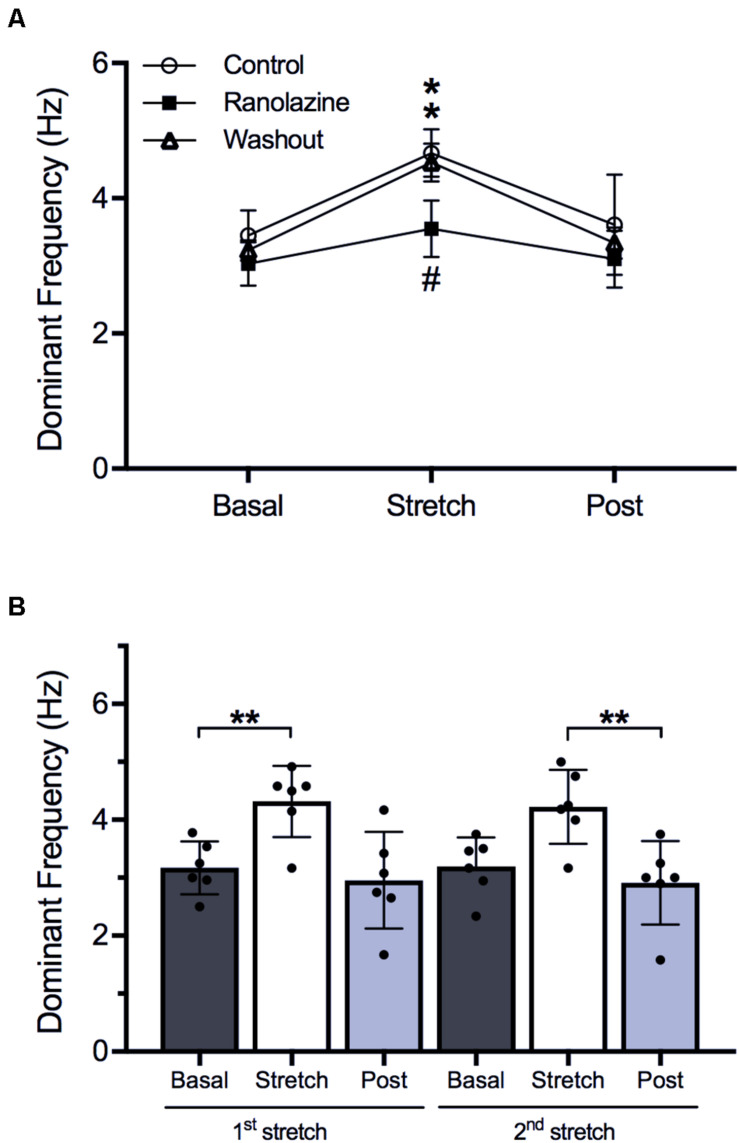
(A) Stretch-induced modifications of dominant frequency under control conditions, under ranolazine action, and after drug washout (n = 4). *p < 0.05 stretch vs. basal, #p < 0.05 ranolazine vs. control and washout. (B) Effects of first and second stretch on dominant frequency (n = 6). **p < 0.01.